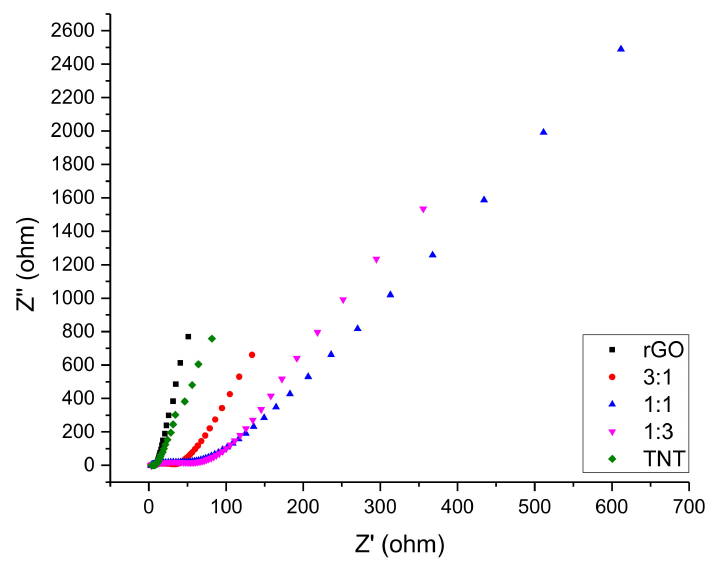
Figure 7. Electrochemical impedance spectroscopy (EIS) of GO/TNT composites.